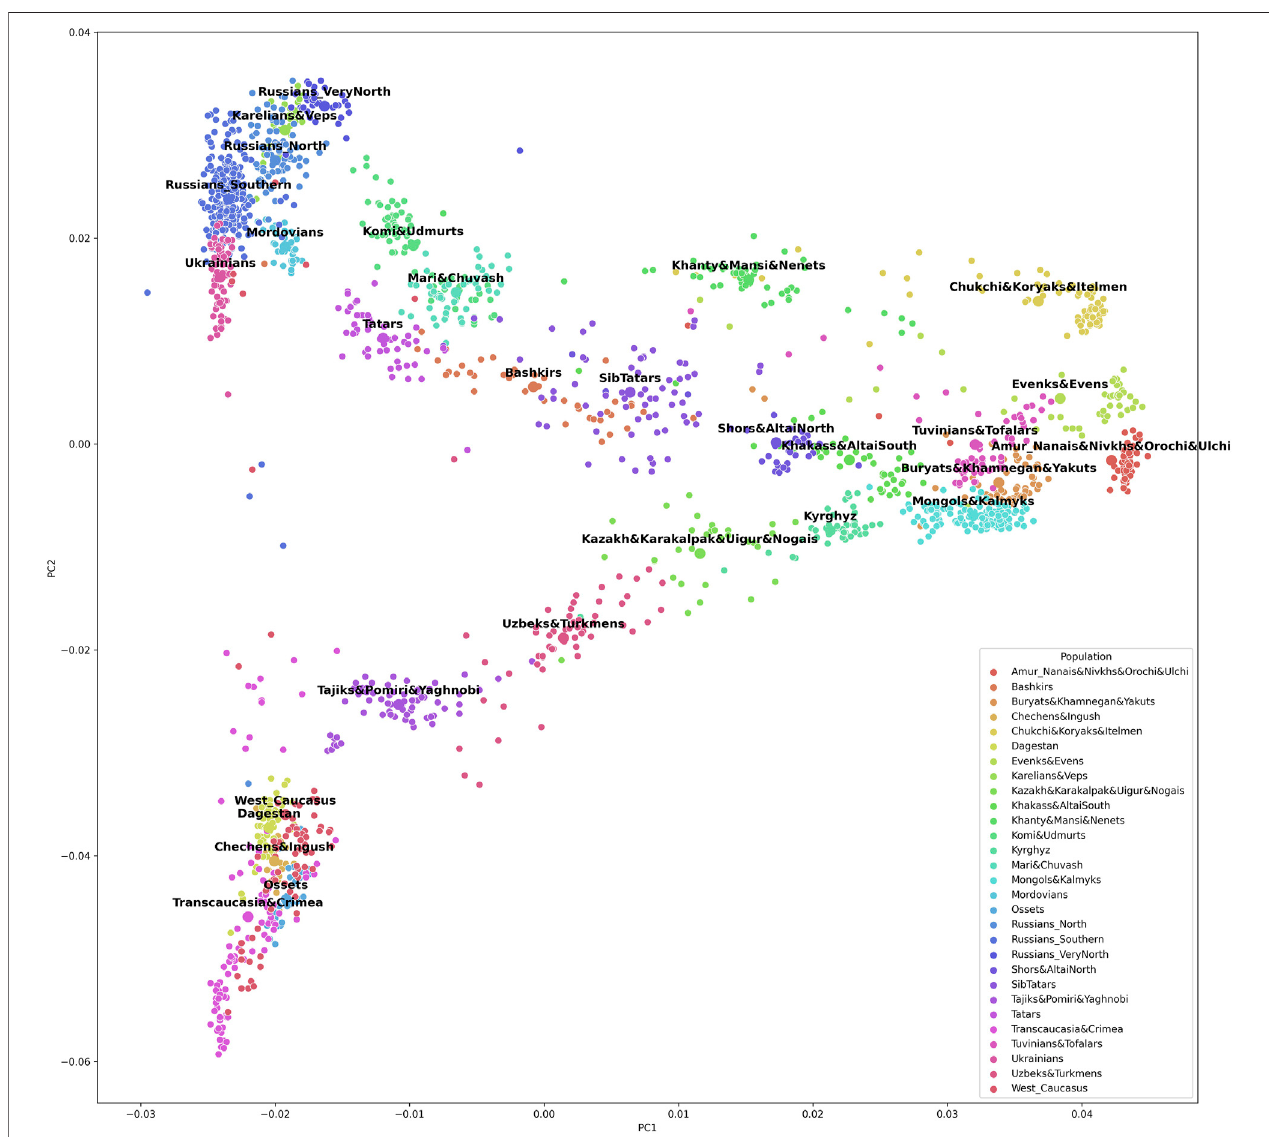
FIGURE 3 | A plot of the fi rst and the second principal components based on the entire 4.5 M SNP